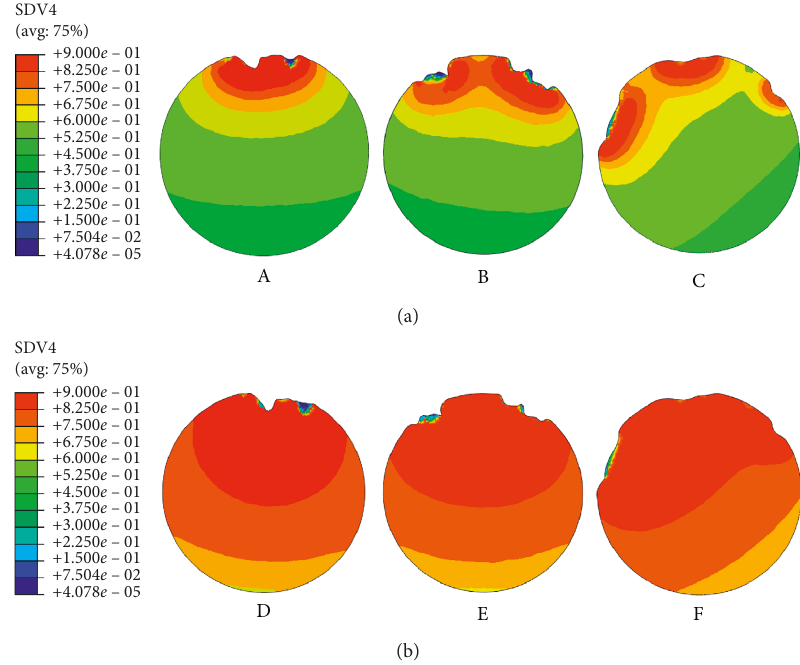
Figure 21: The damage cloud map of steel wires corresponding to the points in Figure 20: (a) step � 301; (b) step � 369.